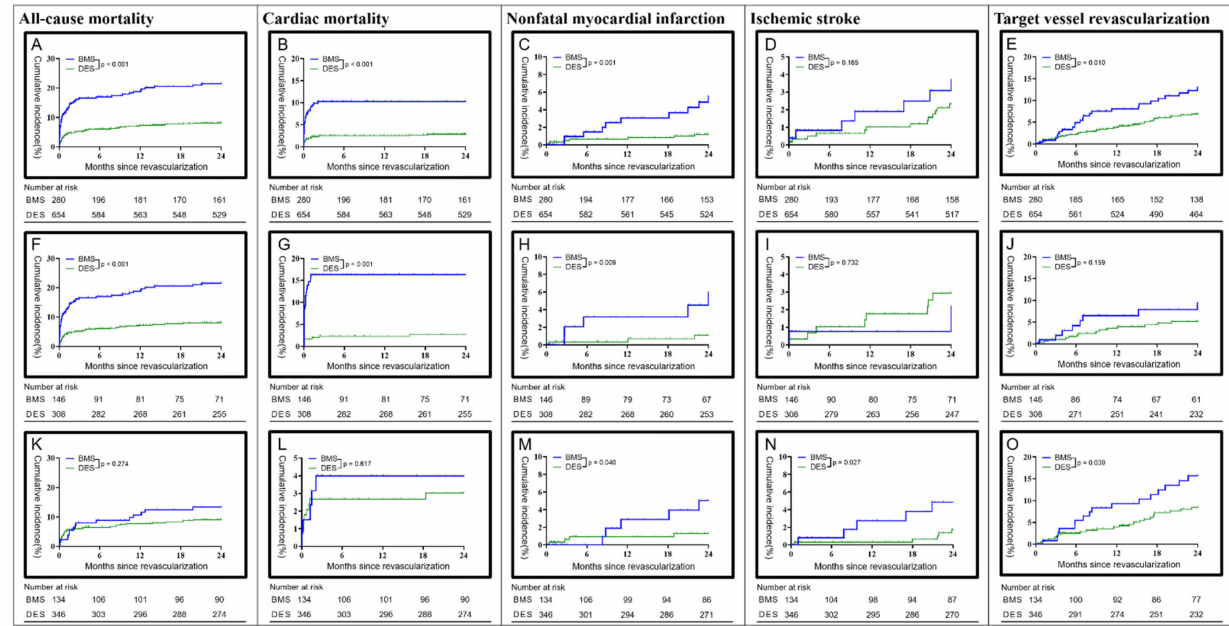
Figure 2. Cumulative 2 year incidence for patients with acute myocardial infarction. Kaplan–Meier estimates of major adverse cardiac events in: ( A – E ) all acute myocardial infarction patients; ( F – J ) ST-elevation myocardial infarction patients; ( K – O ) non-ST-elevation myocardial infarction patients. BMS, bare-metal stent; DES, drug-eluting